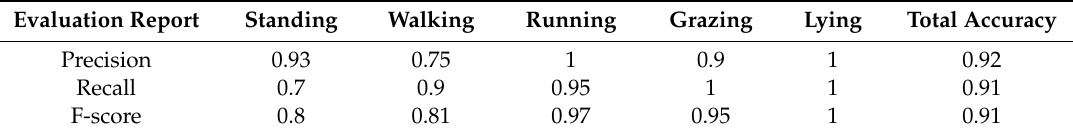
Table 2. Accuracy of the RBF based SVM